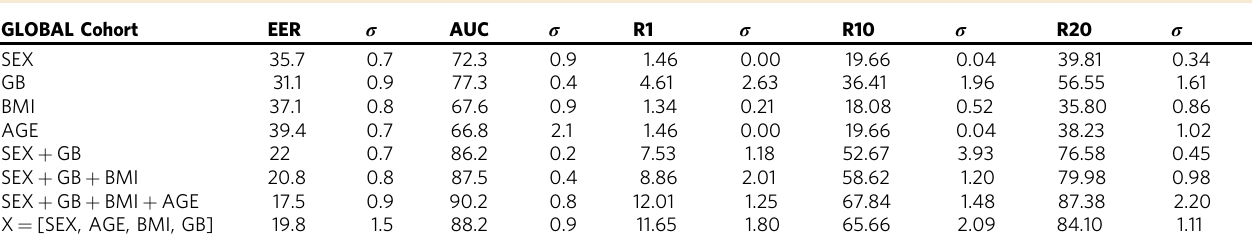
Theresultsfor a DNA-to-Facepredictionstrategy from a setof predictors Xare giveninthe lastrow.All valuesare givenin percentage.Randomperformance isgivenasEER = 0.5,AUC = 0.5,R1 = 1%, R10 = 10%, R20 = 20%. % refers to the percentage of individuals in the gallery ( n = 275, test dataset)